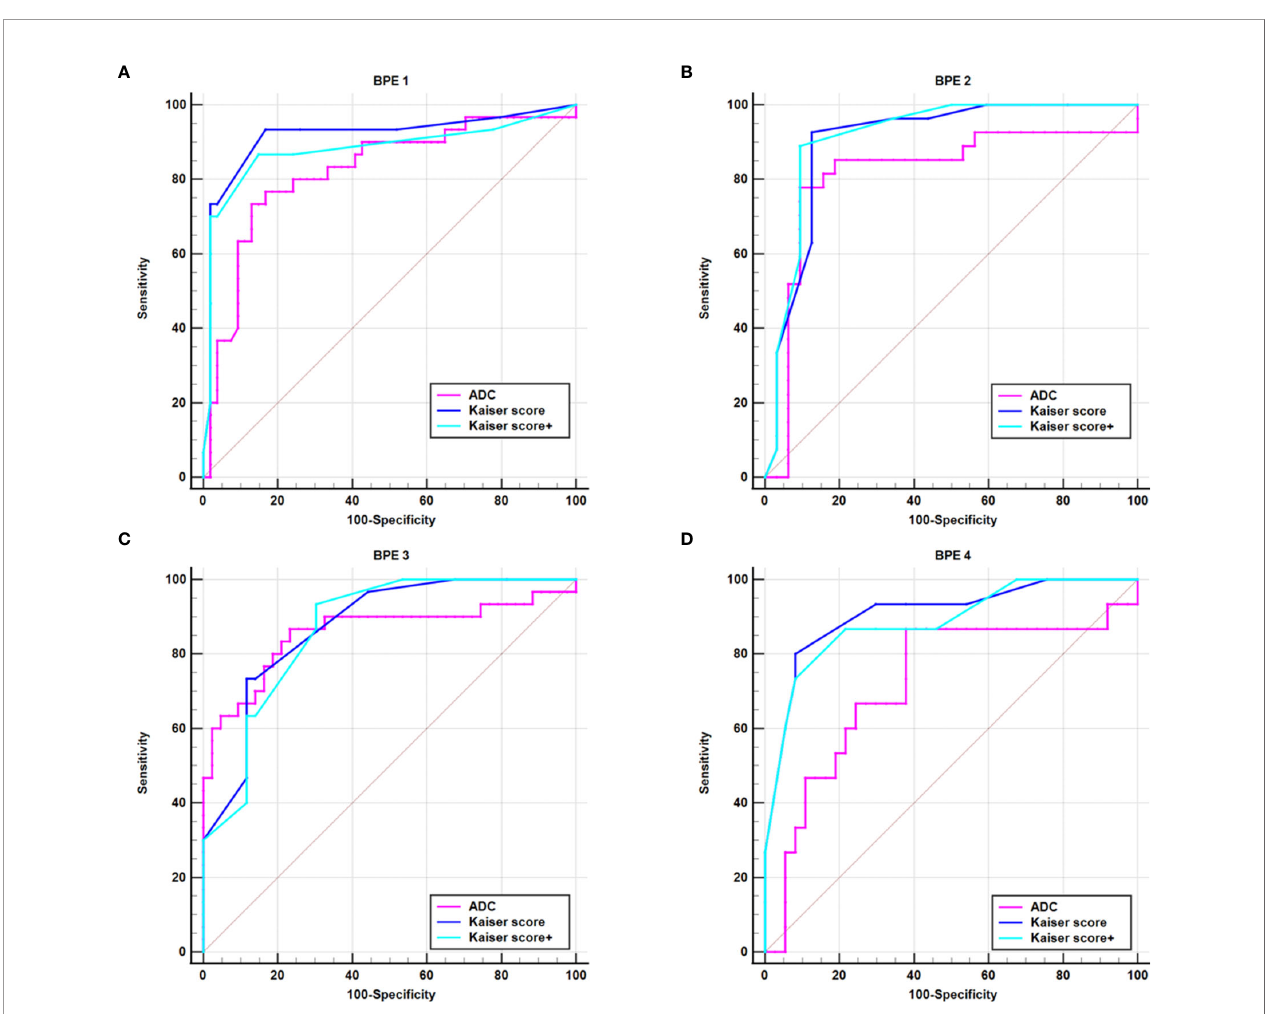
FIGURE 3 | ROC curves show the diagnostic performance of Kaiser score, Kaiser score+, and ADC for different subgroups. (A) BPE 1 group, (B) BPE 2 group, (C) BPE 3 group, (D) BPE 4 group. BPE 1 – 4 represent minimal (<25%), mild (25% – 50%), moderate (50% – 75%), and marked (<75%), respectively. BPE, background parenchyma enhancement.